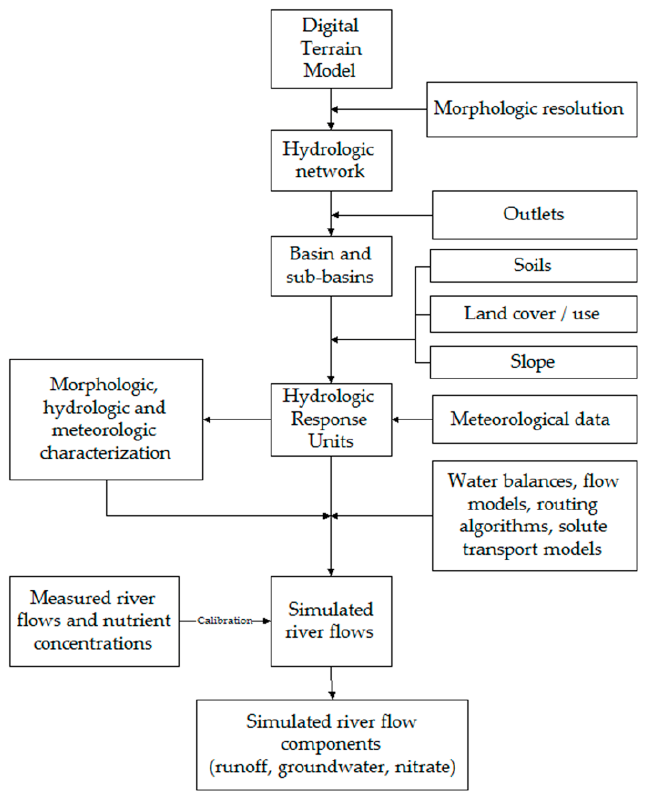
Figure 7. General flowchart of ArcSWAT.